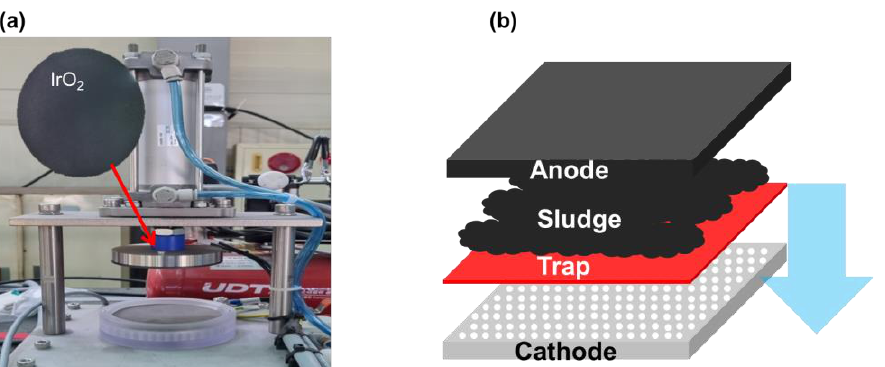
Figure 1. ( a ) Photographs of laboratory-made batch type dehydration system; ( b ) schematic image of the anode and cathode assembly. The anode and cathode material are IrO 2 and SUS304, respectively. Table 1. Experimental parameters for electrodehydration process using IrO 2 anode. Experimental Parameter Values Initial moisture contents (wt.%)